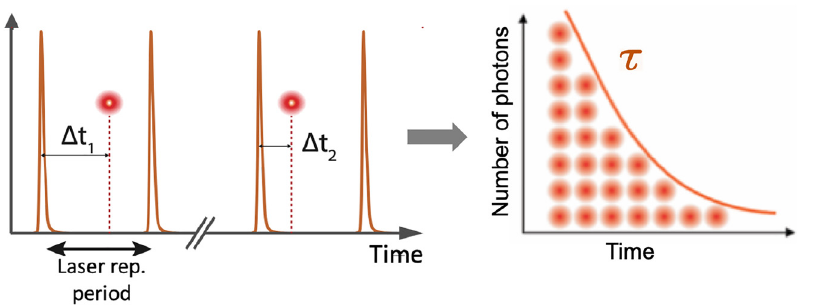
Figure 3: TCSPC principle for fluorescence lifetime measurements. A pulsed laser excites an emitter to its excited state, and the detection times of individual fluorescence photons are repeatedly measured and digitized by the TCSPC electronics timer (left panel). Arrival times Δ t are retrieved to build a fluorescence decay histogram over time. An exponential fit of the histogram is typically used to retrieve the characteristic fluorescence decay time 𝜏 (right